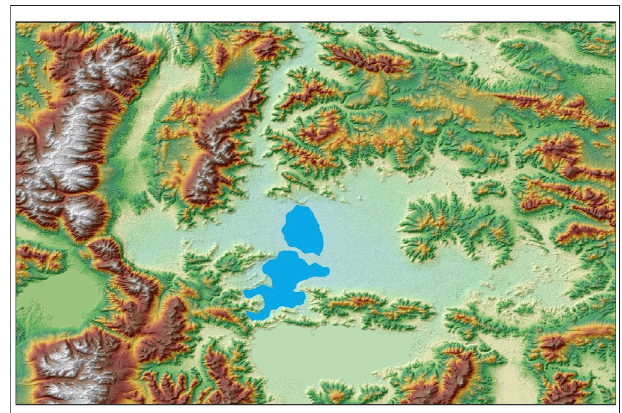
FIGURE 1 | The spatial distribution and topographic features of Zabuye Salt